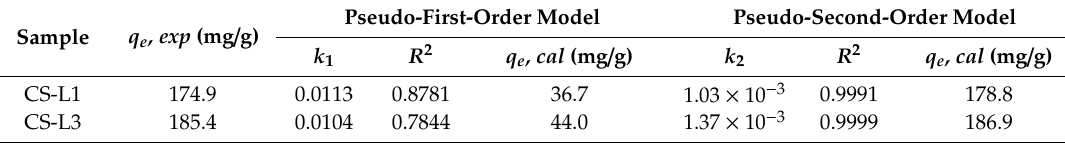
Table 3. Kinetics parameters for adsorption of Cu(II) on CS membranes.